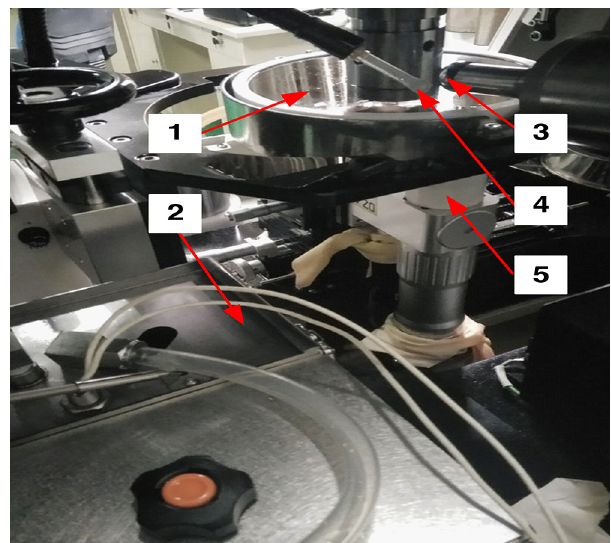
Fig. 3. TFM-150 fi lm thickness measuring apparatus: 1-disc, 2-oil heating tank, 3-ball, 4-oil nozzle, and